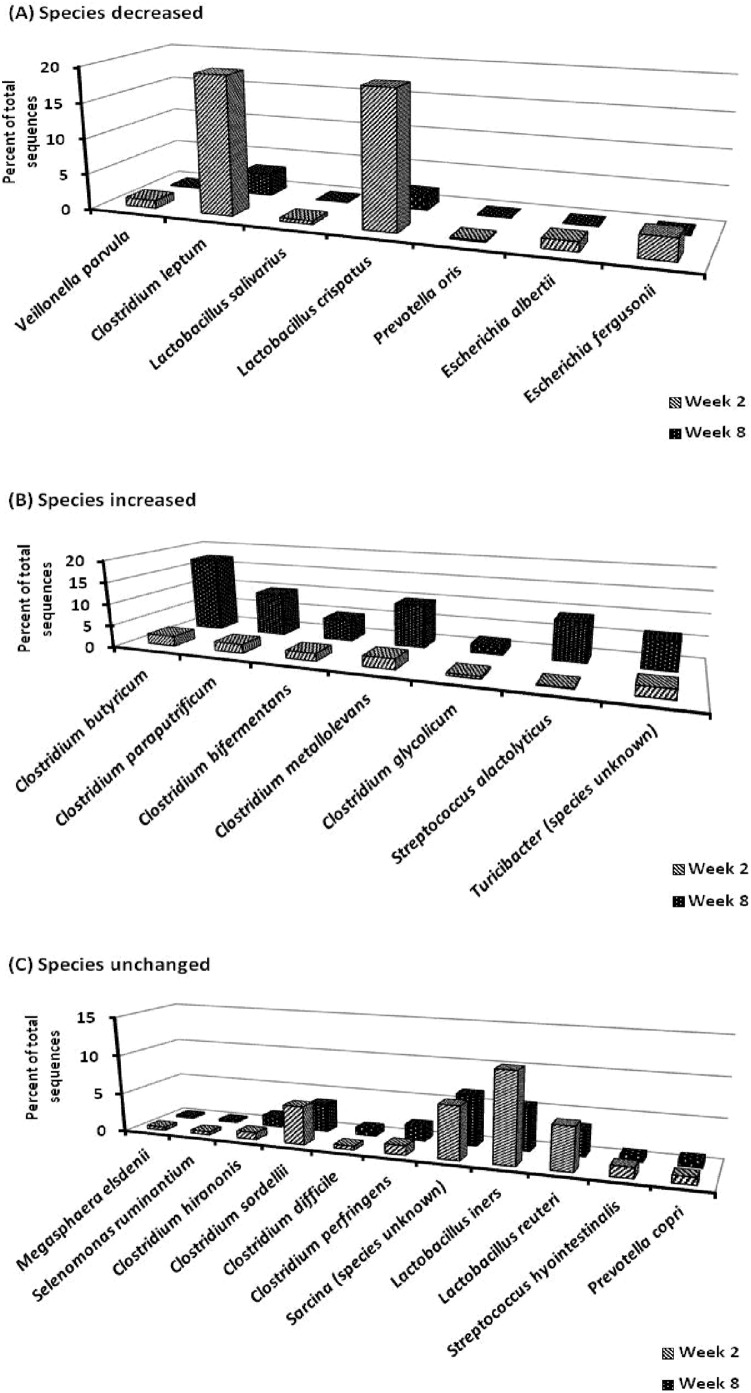
Ileal mucosa bacterial species (expressed as percentage of sequences) in pigs from week 2 to 8 post-weaning.Of the 25 bacterial species with levels of sequencing ≥1% of total sequences seven decreased (A), seven increased (B), and eleven remained unchanged (C) from week 2 to 8 post-weaning. Values are least squared means.